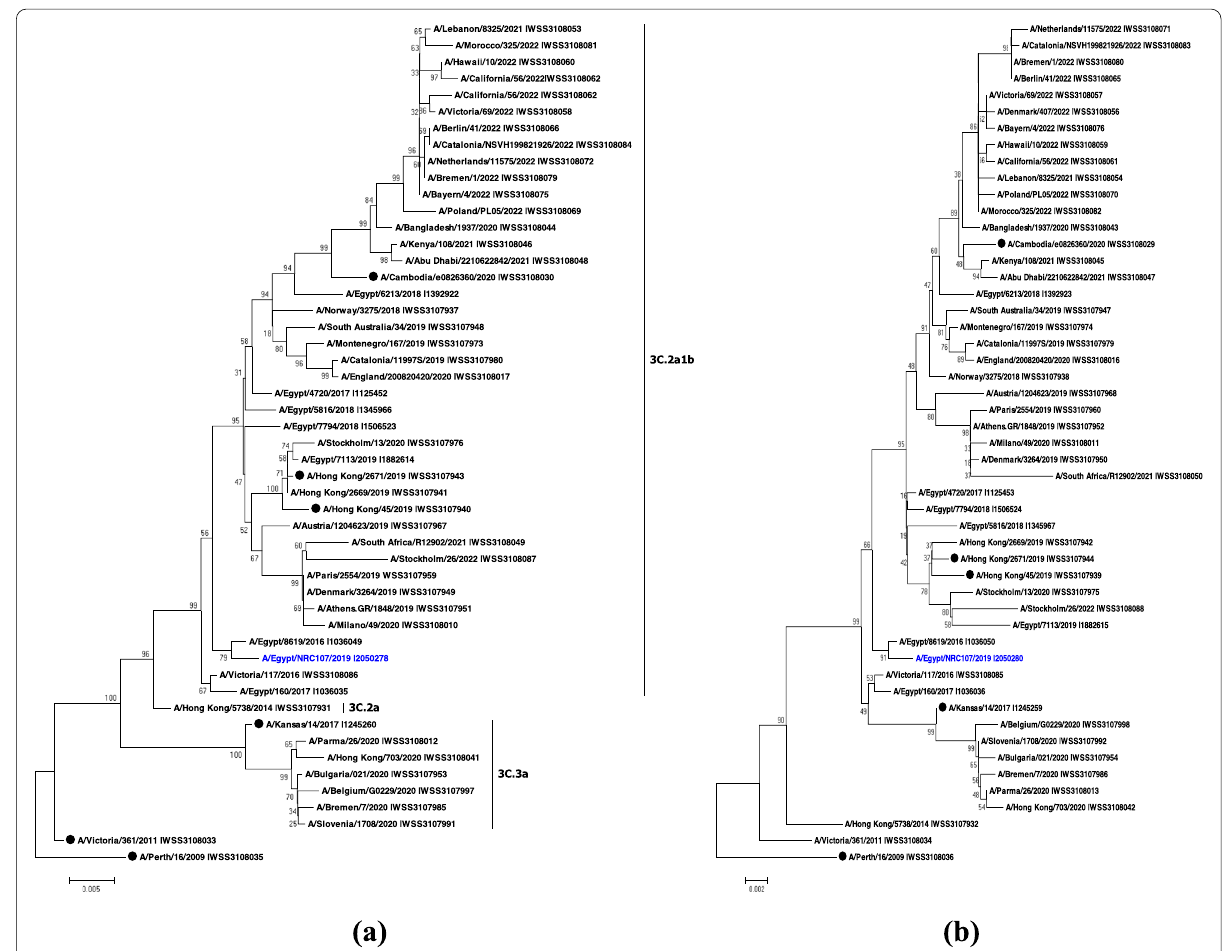
Fig. 4 Phylogenetic analysis of the full HA ( a ) and NA ( b ) sequences from the studied candidate influenza vaccine strain A/Egypt/NRC107/2019 (H3N2). The tree is rooted with A/Perth/16/2009 (H3N2). Our studied candidate vaccine strain is indicated in blue color. Vaccine strains A/ Kansas/14/2017 (egg-based, 2019–2020 season), A/Hong Kong/2671/2019 (egg-based, 2020–2021), A/Hong Kong/45/2019 (cell-based, 2020–2021 season), and A/Cambodia/e0826360/2020 (2021–2022 season) are indicated with black